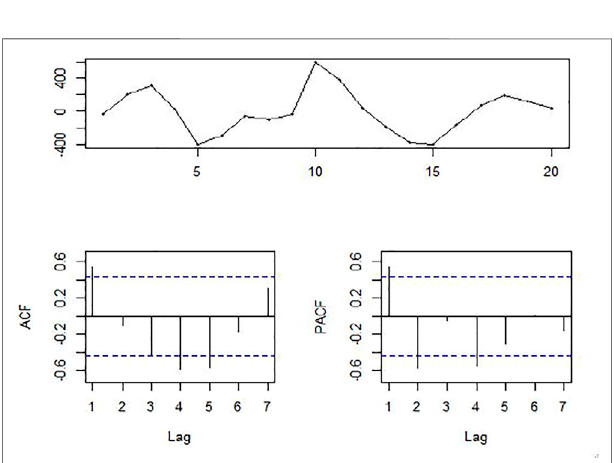
FIGURE 3 | Autocorrelation and partial autocorrelation plots of residuals of the Gamma model.